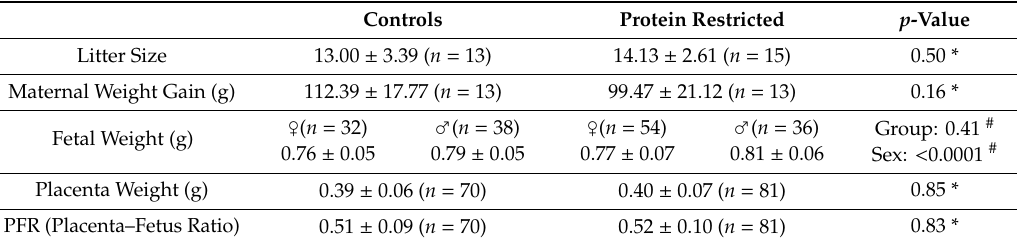
Table 1. Litter and fetus characteristics at embryonic day 17 (E17).